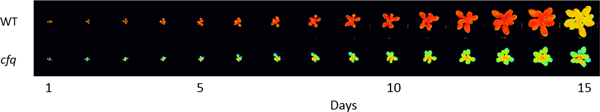
Overview of the photosynthesis activity ΦII and growth of cfq and wild type (col-0) plants under fluctuating light conditions. The mutant is clearly distinguished by its distinct area and colors (red and blue representing high and low ΦII values respectively).